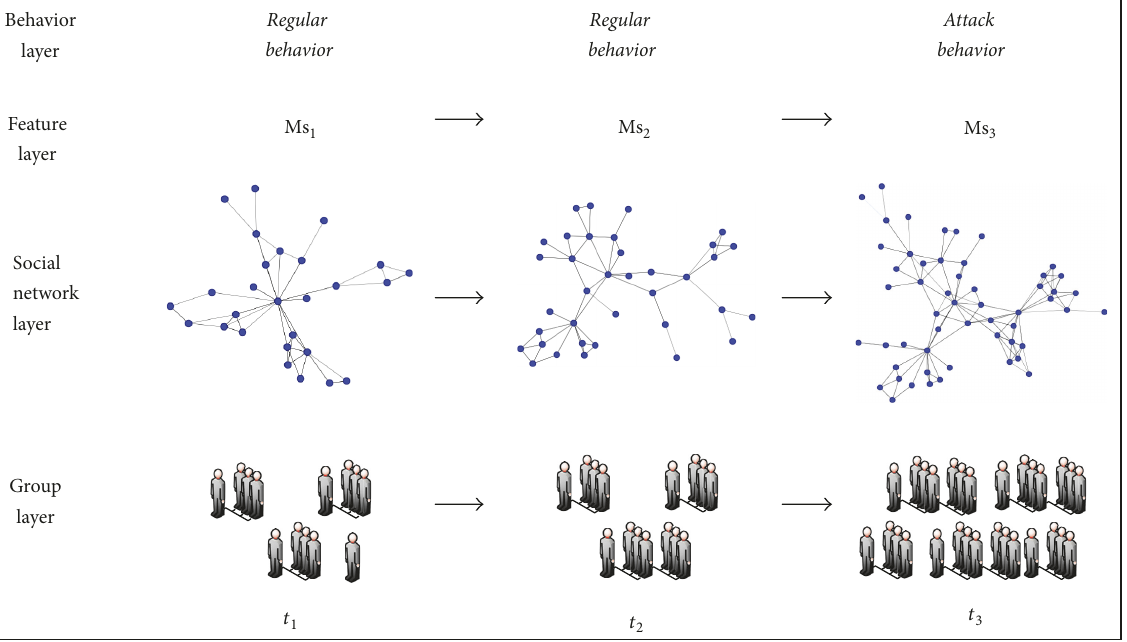
Figure 1: Descriptive figure of correlation between the network and behavior of a terrorist group.